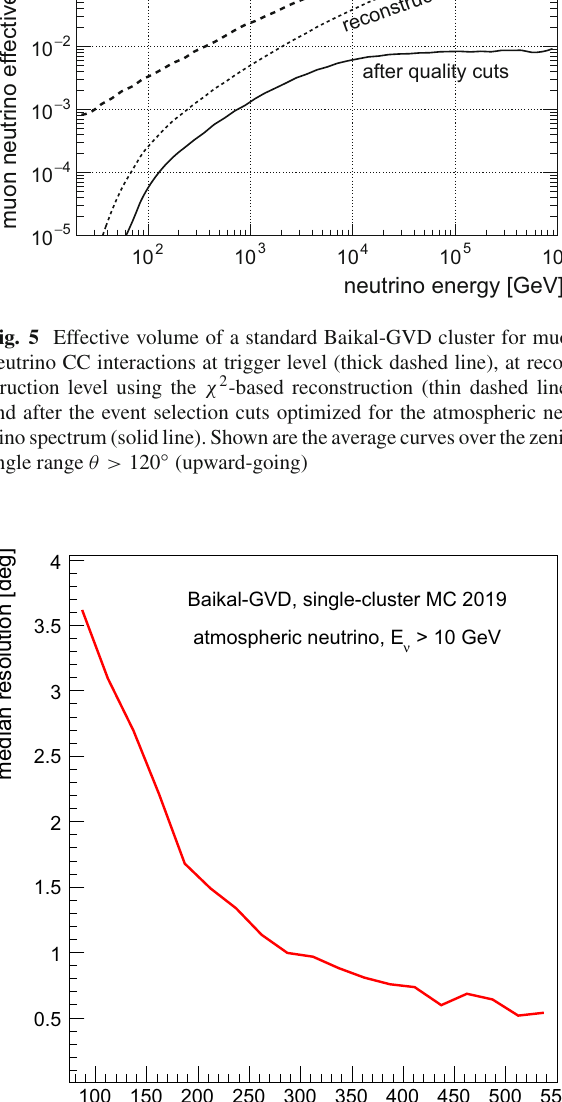
reconstruction, machine learning, etc.). For comparison, the angular resolution in the Baikal-GVD cascade analysis is typically about 4 ◦